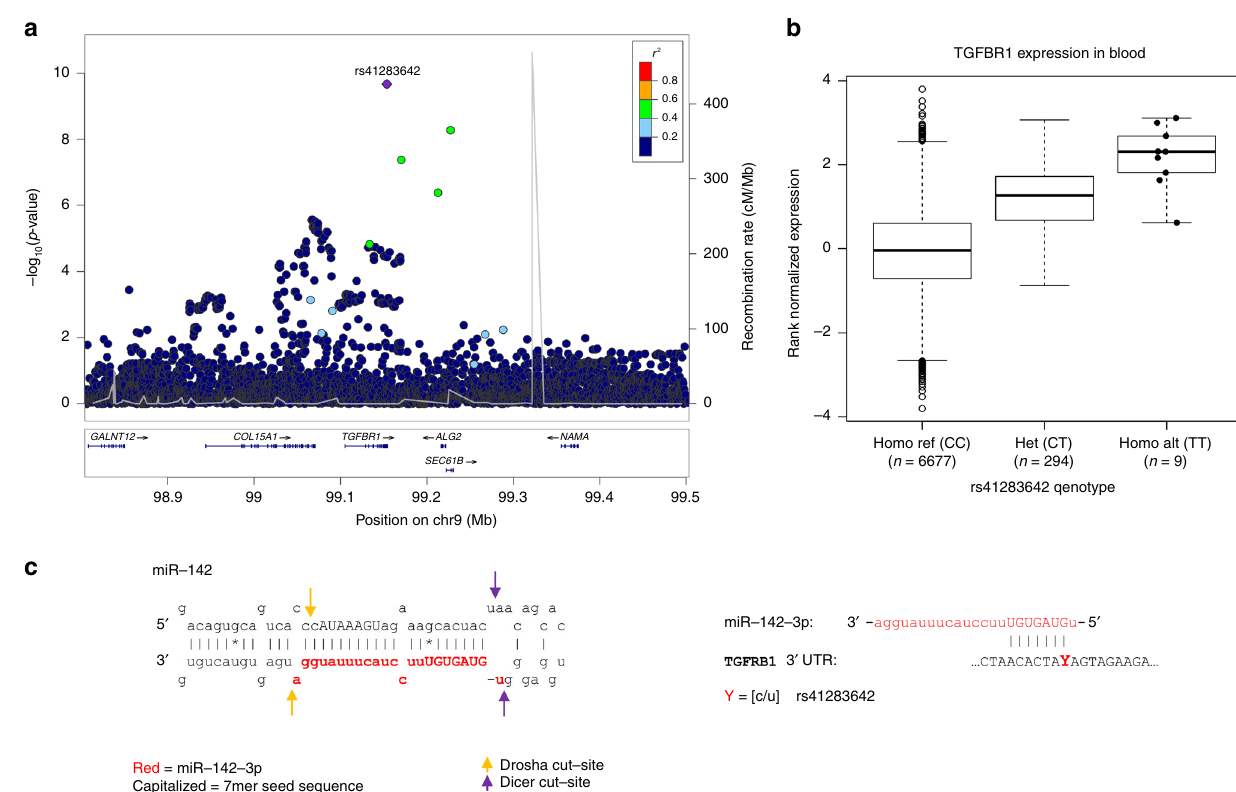
Fig. 3 Variant in the 3 ’ UTR of TGFBR1 increases TGFBR1 expression in blood and associates with reduced asthma risk. a Locus plot showing association with asthma where the lead variant rs41283642 is colored in purple. Other variants are colored by degree of correlation ( r 2 ) with the lead variant. b Box plot showing the expression of TGF β R1 in blood of rs41283642_T non-carriers (CC, N = 6677), heterozygotes (CT, N = 294) and homozygotes (TT, N = 9) based on RNA-Seq data; P = 7.24E-101, effect = 1.18 S.D. corresponding to 15.2% increased expression of TGFBR1 per allele. The bottom and top of the boxes correspond to the 25th (Q1) and 75th (Q3) percentiles, the line inside the box corresponds to the median, and the whiskers are located at max(min (Expression), Q1 – 1.5 IQR) and min(max(Expression), Q3 + 1.5 IQR), respectively (where IQR is the interquartile range = Q3 – Q1). c Schematic representation of the primary miR-142 transcript, derived from MIR142 located on chromosome 17q22. The 3 ′ end of miR-142 forms miR-142-3p which is known to targets multiple mRNA transcripts including TGFRB1. The predicted binding site for miR-142-3p at the 3 ′ UTR of TGFBR1 is shown wherein Y represents the location of the rs41283642. The reference allele is C, forming a 7mer perfect complementary sequence to the seed sequence of miR-142- 3p whereas the protective asthma T_allele (U in RNA), disrupts the 7mer binding site. Source data are provided as a Source Data fi